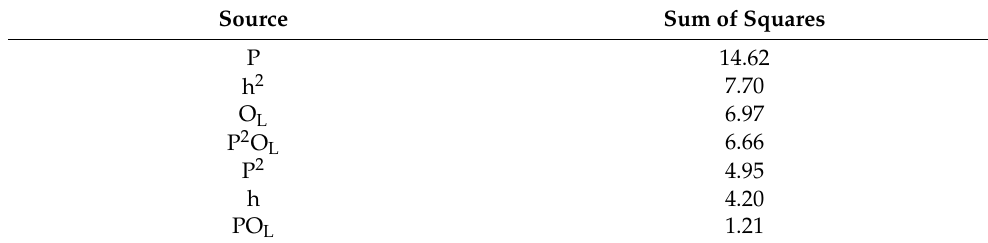
Table 13. Significant control factors for the RSD